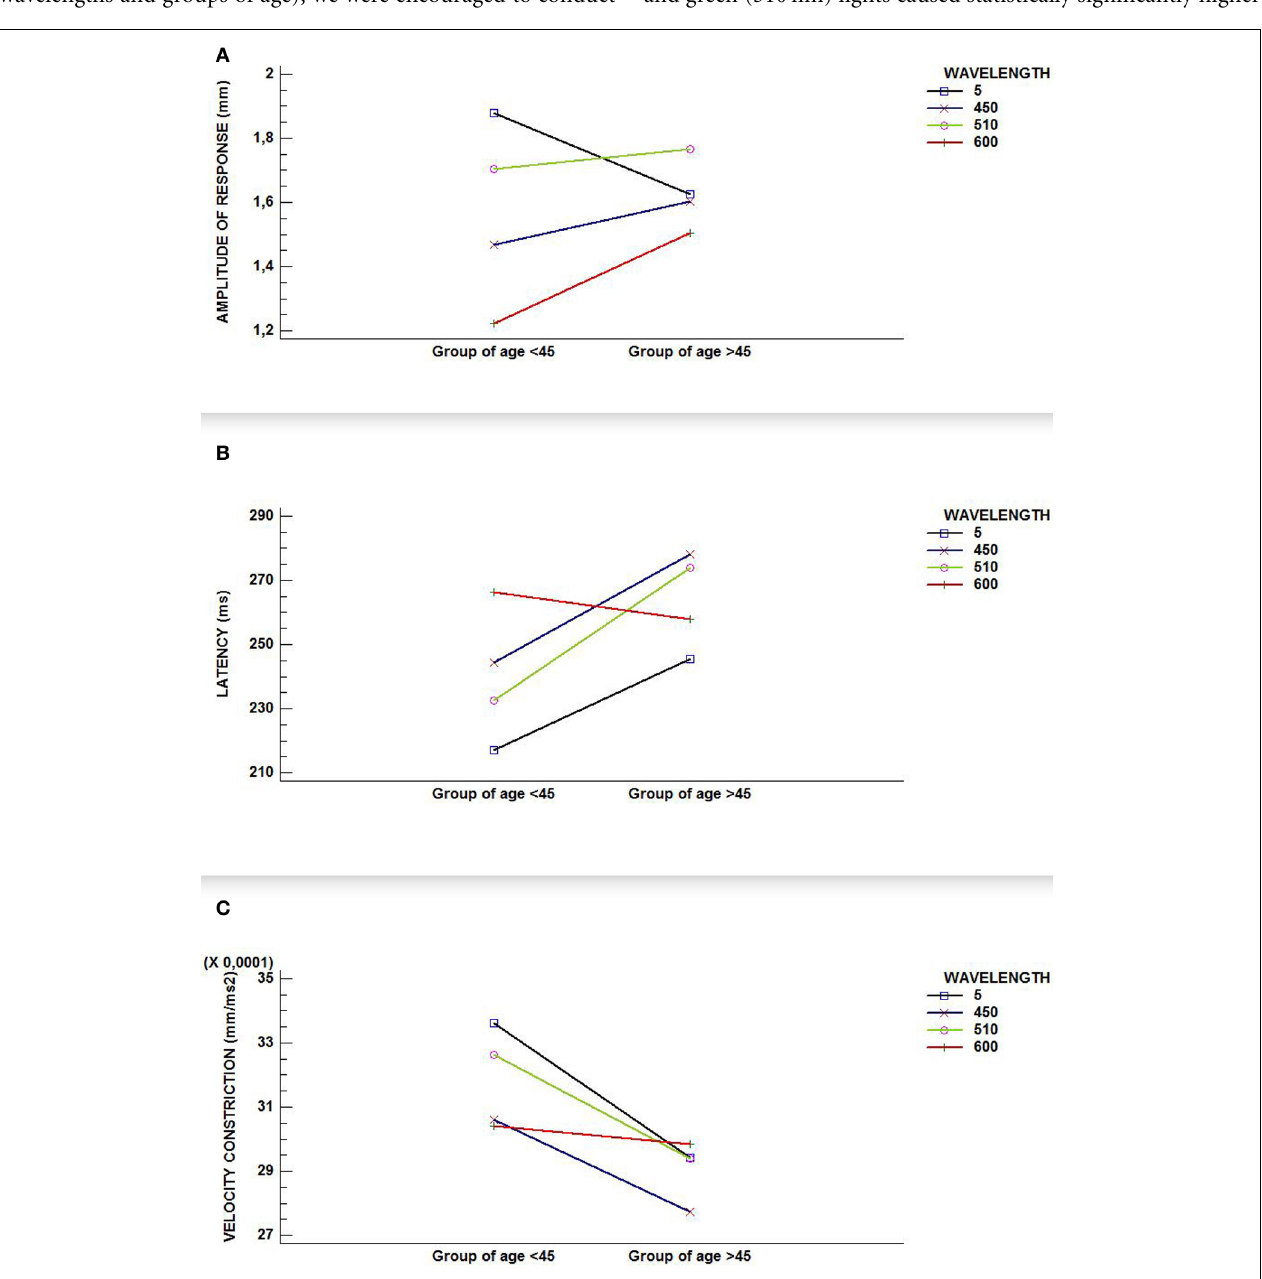
FIGURE 2 | Interaction graphics for (A) amplitude of response; (B) latency; and, (C) velocity of constriction. Although all figures show an interaction between factors (wavelength and age group) in our sample, only (A) reflects a statistically significant interaction effect ( p -value < 0.000).